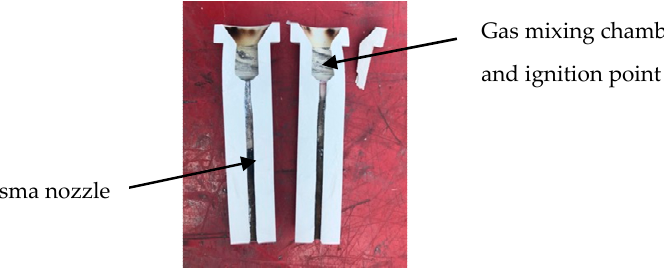
Figure 5. Thermal shock damage of the aluminium nitride Figure 5 . Thermal shock damage of the aluminium nitride tube . Figure 5 . Thermal shock damage of the aluminium nitride tube .